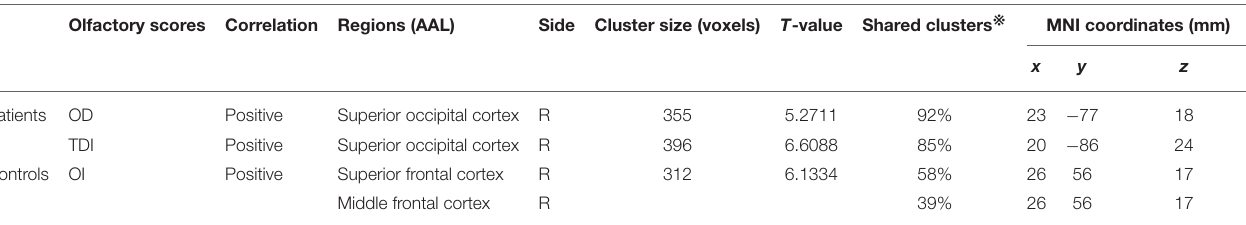
TABLE 4 | Correlation between olfactory scores and regional gray matter volume. Olfactory scores Correlation Regions (AAL) Side Cluster size (voxels) T -value Shared clusters ※